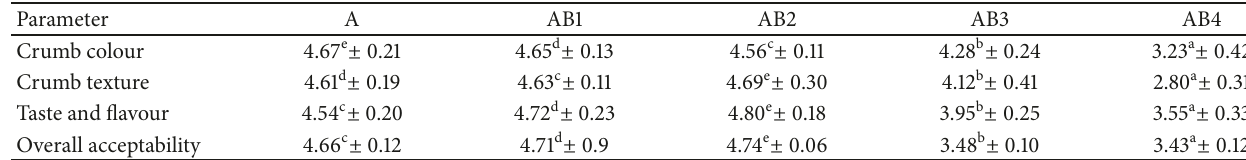
Table 5: Sensory evaluation of wheat and walnut bread